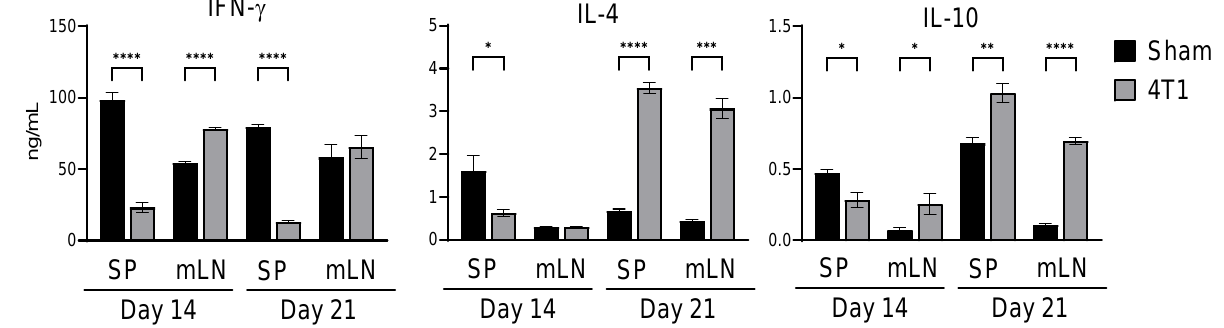
Figure 1. Cytokine production by splenocytes and mLN cells in 4T1 tumor mice. At day 21 of transplantation into the right flank transplantation, the splenocytes and mLNs from control (Sham) or tumor (4T1)-bearing mice were isolated and stimulated with plate-bound anti- CD3ε mAb for 48 h. IFN- γ , IL-4, and IL-10 cytokines in the culture supernatant were detected by ELISA. Data are shown from a representative experiment from four independent experiments. All data are presented as mean ± SEM and assessed with the Mann–Whitney U test. * p < 0.05; ** p < 0.01; *** p < 0.001; **** p < 0.0001.